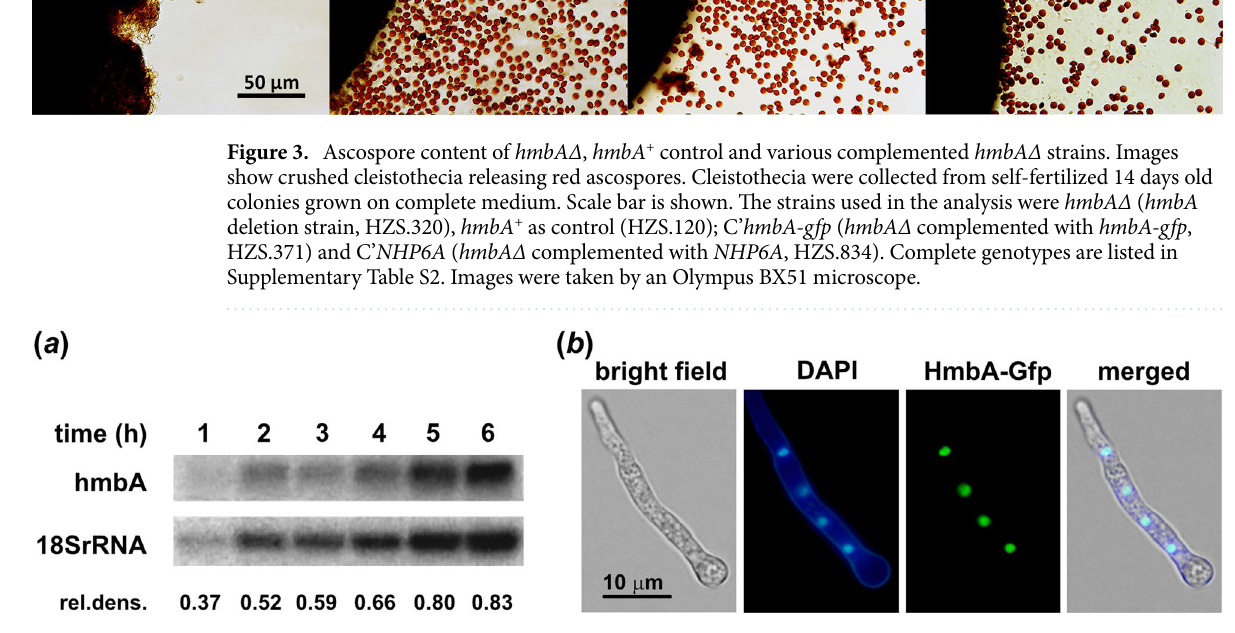
Figure 4. Expression profile of hmbA and intracellular localization of the gene product. ( a ) Northern blot analysis of the mRNA level of hmbA from germination to mycelial growth (1–6 h) in the hmbA + strain HZS.117. Loading of RNA was estimated by hybridization with an 18S rRNA specific DNA probe. hmbA mRNA levels relative to that of the housekeeping 18S rRNA gene were calculated by normalization of the optical density of each amplified hmbA band shown in Northern blot to that of the 18S rRNA gene by using ImageJ. Used medium was MM with 5 mM urea as sole nitrogen-source. ( b ) Subcellular localization of HmbA-Gfp with DNA staining (DAPI) of young hypha in C’ hmbA-gfp strain (HZS.371). Conidiospores were germinated for 8 h in MM at 37 °C. Cells were stained for DNA (DAPI) and examined by fluorescence microscopy (Zeiss 49 and 15 filter sets were used for DAPI and Gfp, respectively). Scale bar represents 10 μm. Complete genotypes are listed in Supplementary Table